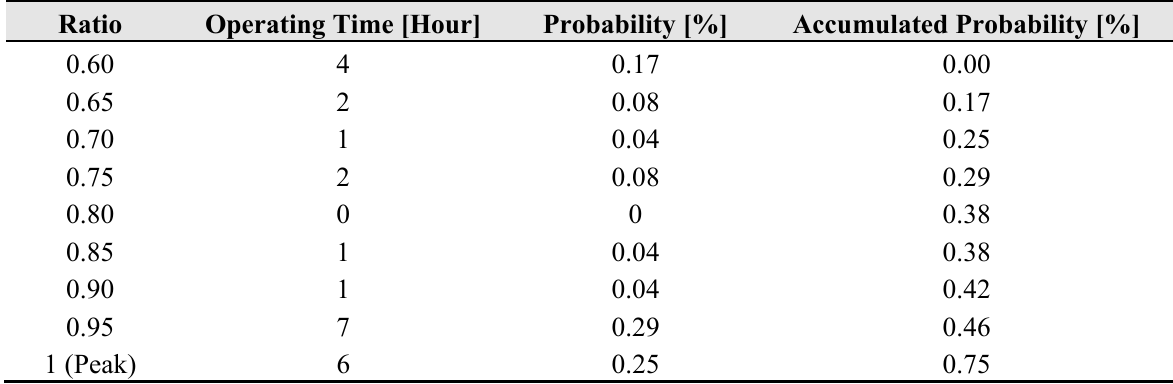
Table 4. Peak capacity of area and capacity of DG.